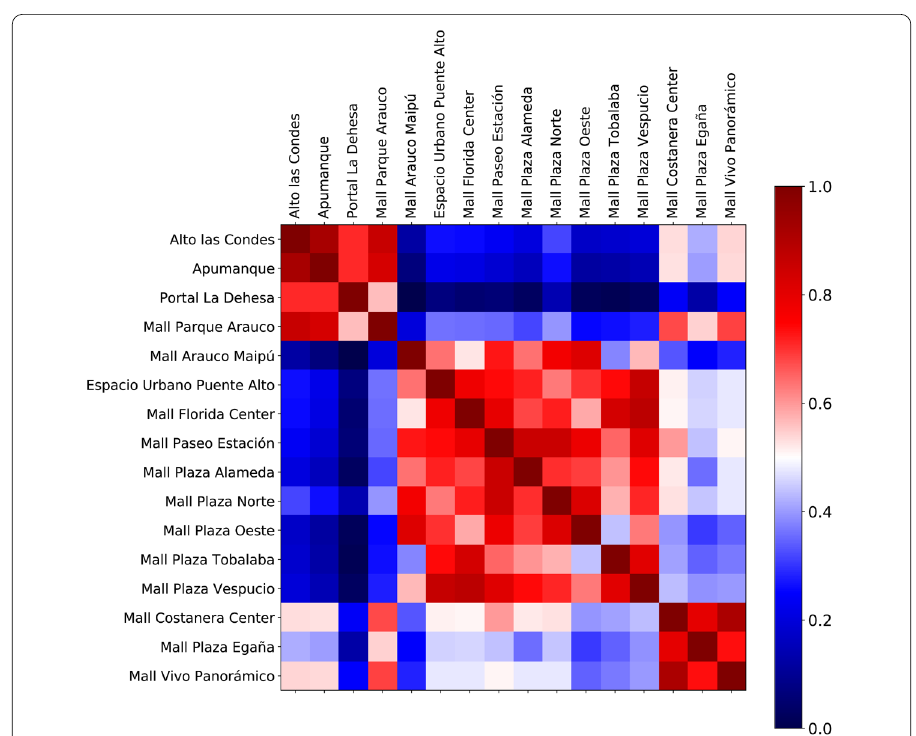
Figure 11 Similarity matrix between malls. The similarity between a pair of malls was computed as the Kolmogorov–Smirnov distance between the customer profile distributions of the malls. Malls were clustered into 3 groups using spectral clustering